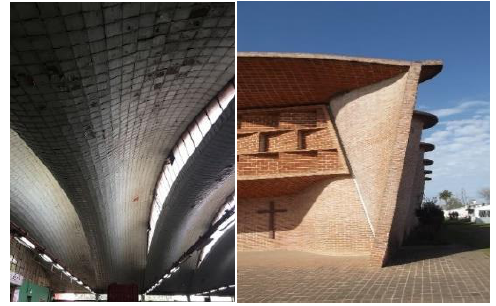
Figure 1: (left) Porto Alegre Market (1970-72), Porto Alegre - Brazil. (right) Church of Cristo Obrero (1958-60), Atlántida - Uruguay.